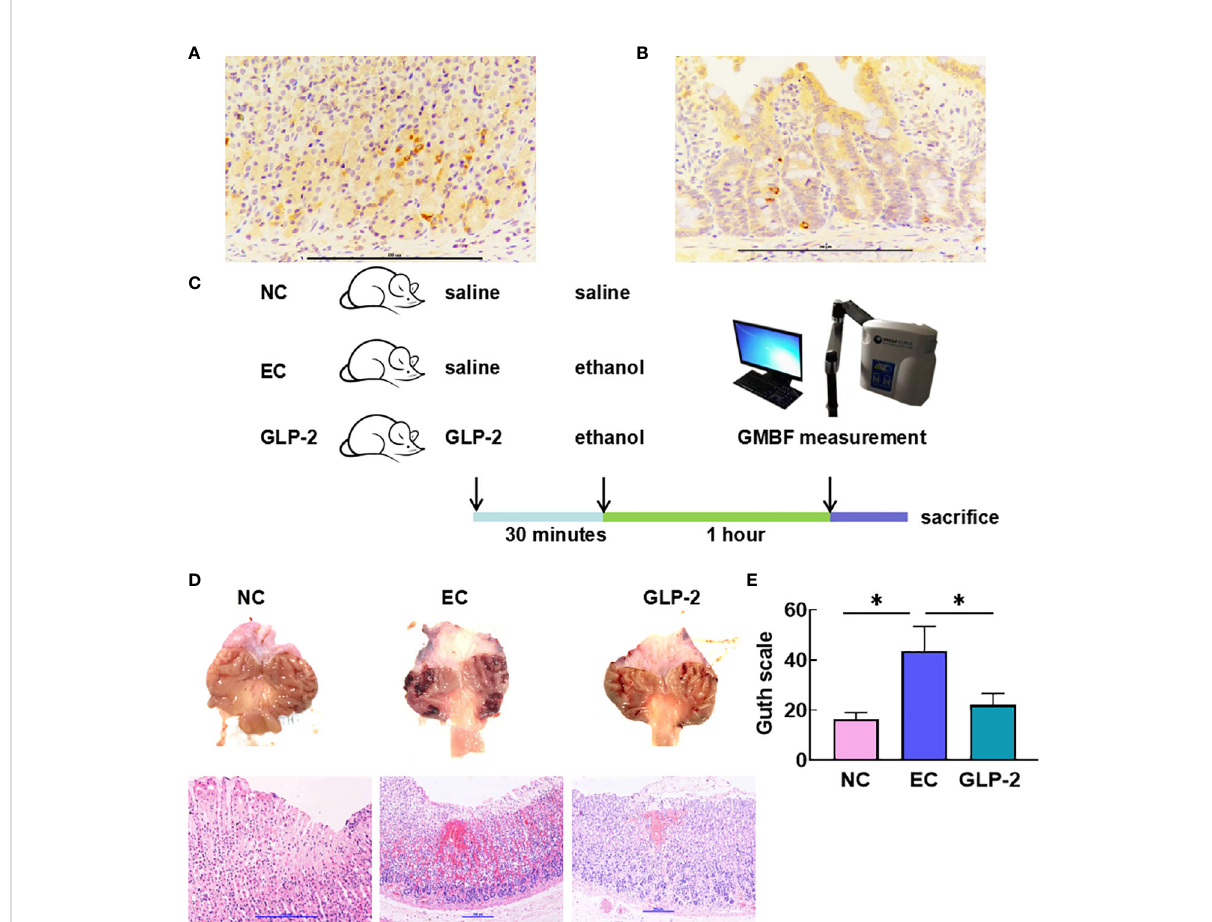
FIGURE 2 Effect of GLP-2 on the macroscopic and microscopic appearance of the ethanol-treated gastric mucosa among normal control (NC), ethanol model (EC) and glucagon-like peptide-2 (GLP-2) groups. (A, B) Distributions of glucagon-like peptide-2 receptor (GLP-2R) in the stomach (A) and colon tissue as a positive control (B) . (C) Schematic of the animal experiments. (D) Macroscopic appearance (upper), haematoxylin-eosin staining (lower). (E) The gastric injury index according to the Guth scale. Data are presented as the mean ± SD. *P <